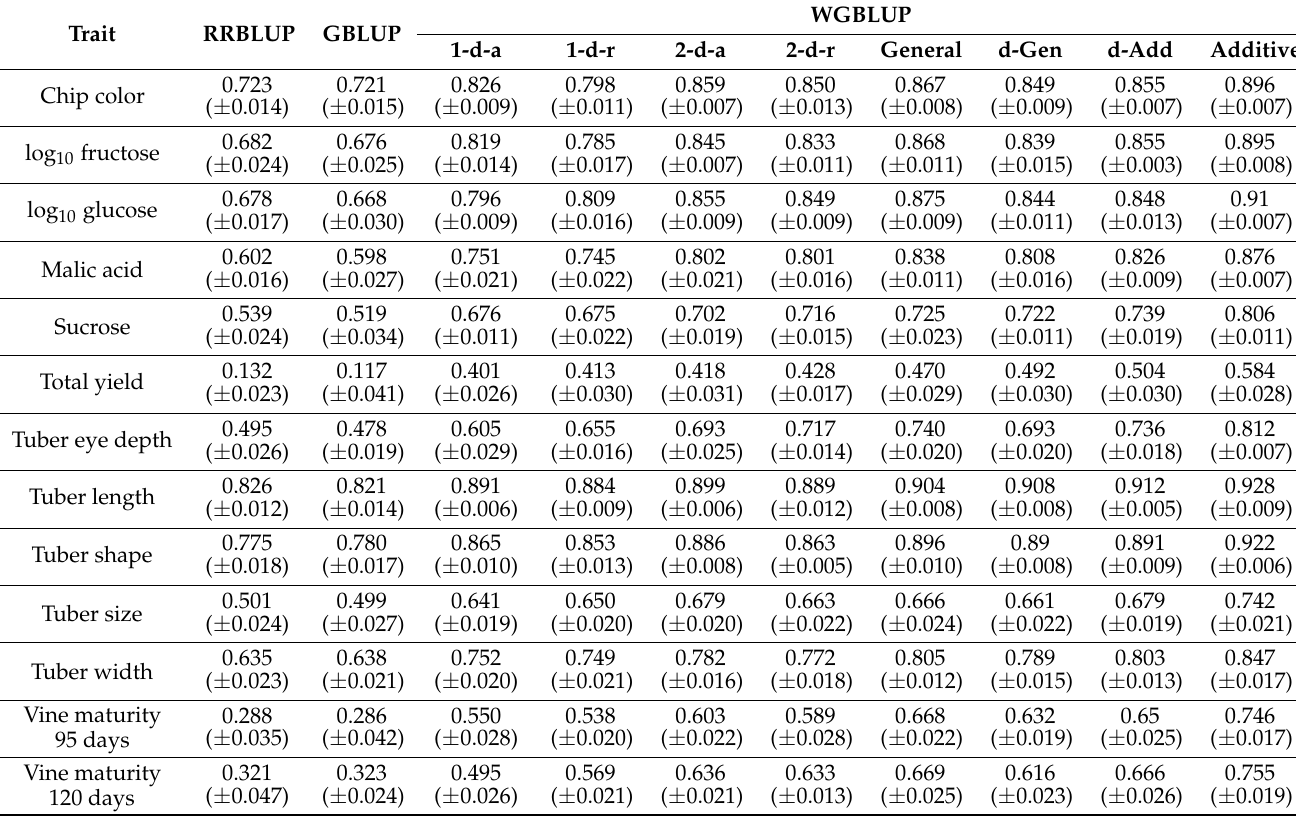
Table 5. Comparison of genomic selection (GS) models in 13 phenotypic traits collected in the SolCAP potato diversity panel. Mean and standard deviation of Pearson’s correlation obtained by 10-fold cross validation in 10 replicates. SNP weights for WGBLUP were obtained from − log 10 p -values of different GWASpoly